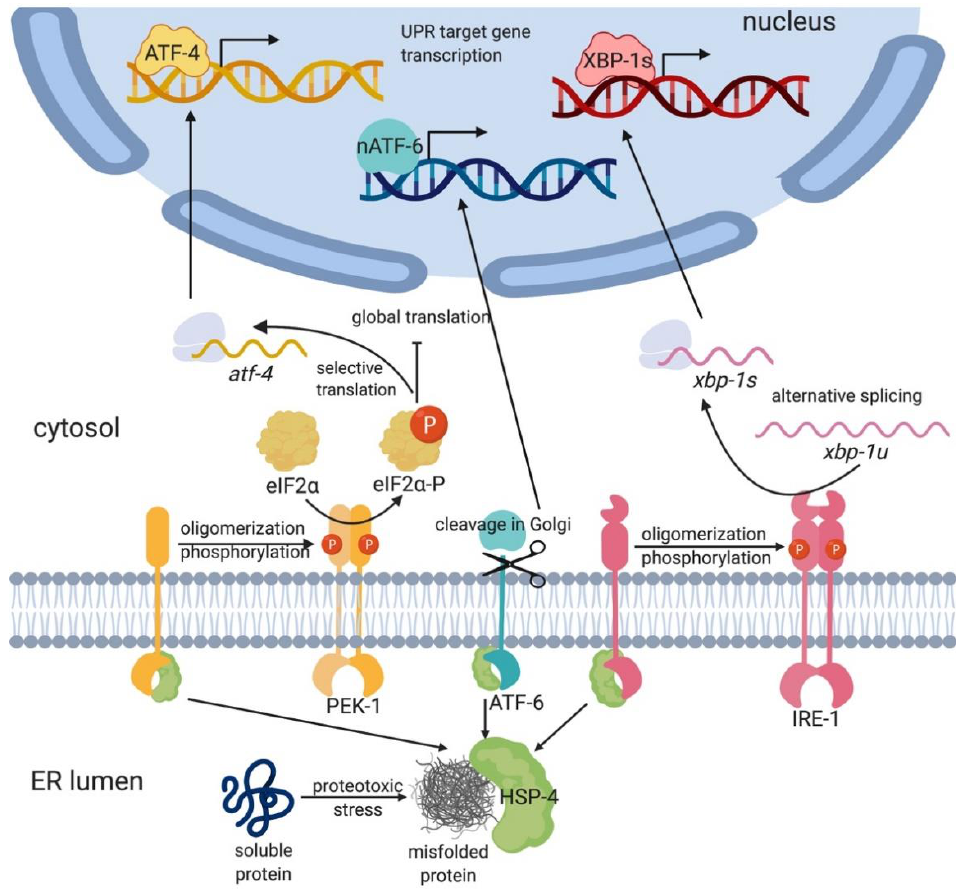
Figure 1. Overview of the canonical endoplasmic reticulum unfolded protein response (UPR-ER) pathways. In higher eukaryotes, upon sensing misfolded proteins by HSP-4/BiP, the three UPR-ER branches—IRE-1 α , PEK-1, and ATF-6—are activated to mount distinct and collective downstream transcriptional and translational programs to promote protein folding, processing, and secretion, thereby reducing the load of misfolded proteins in the ER lumen and alleviating ER stress. Abbreviations: ATF-4: Activating Transcription Factor 4; ATF-6: Activating Transcription Factor 6; eIF2 α : Eukaryotic Initiation Factor 2 α ; HSP-4/BiP: heat shock protein 4/ Binding immunoglobulin protein; IRE-1 α : Inositol-Requiring-Enzyme 1 α ; PEK-1: human PERK kinase homolog; UPR: unfolded protein response; xbp-1 : X-box Binding Protein homolog 1. (Figure created with Biorender.com, Toronto, ON, Canada).